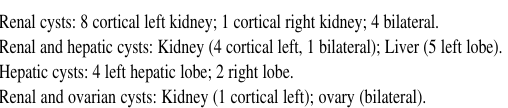
Table 1: Characteristics of cysts. Renal cysts: 8 cortical left kidney; 1 cortical right kidney; 4 bilateral. Renal and hepatic cysts: Kidney (4 cortical left, 1 bilateral); Liver (5 left lobe). Hepatic cysts: 4 left hepatic lobe; 2 right